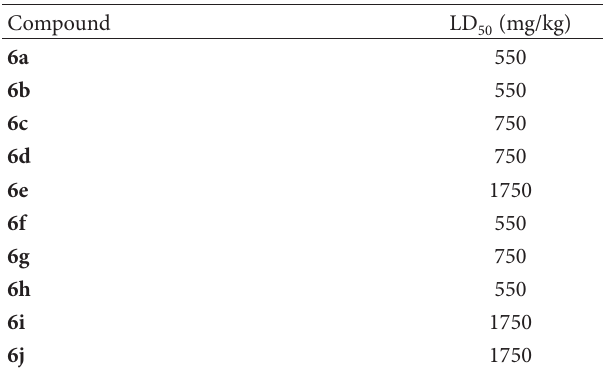
procedure. Swiss albino mice (female) weighing between 20 and 30 g were given orally a particular dose say 175 mg/kg and observed for a period of 48 hrs for any mortality.